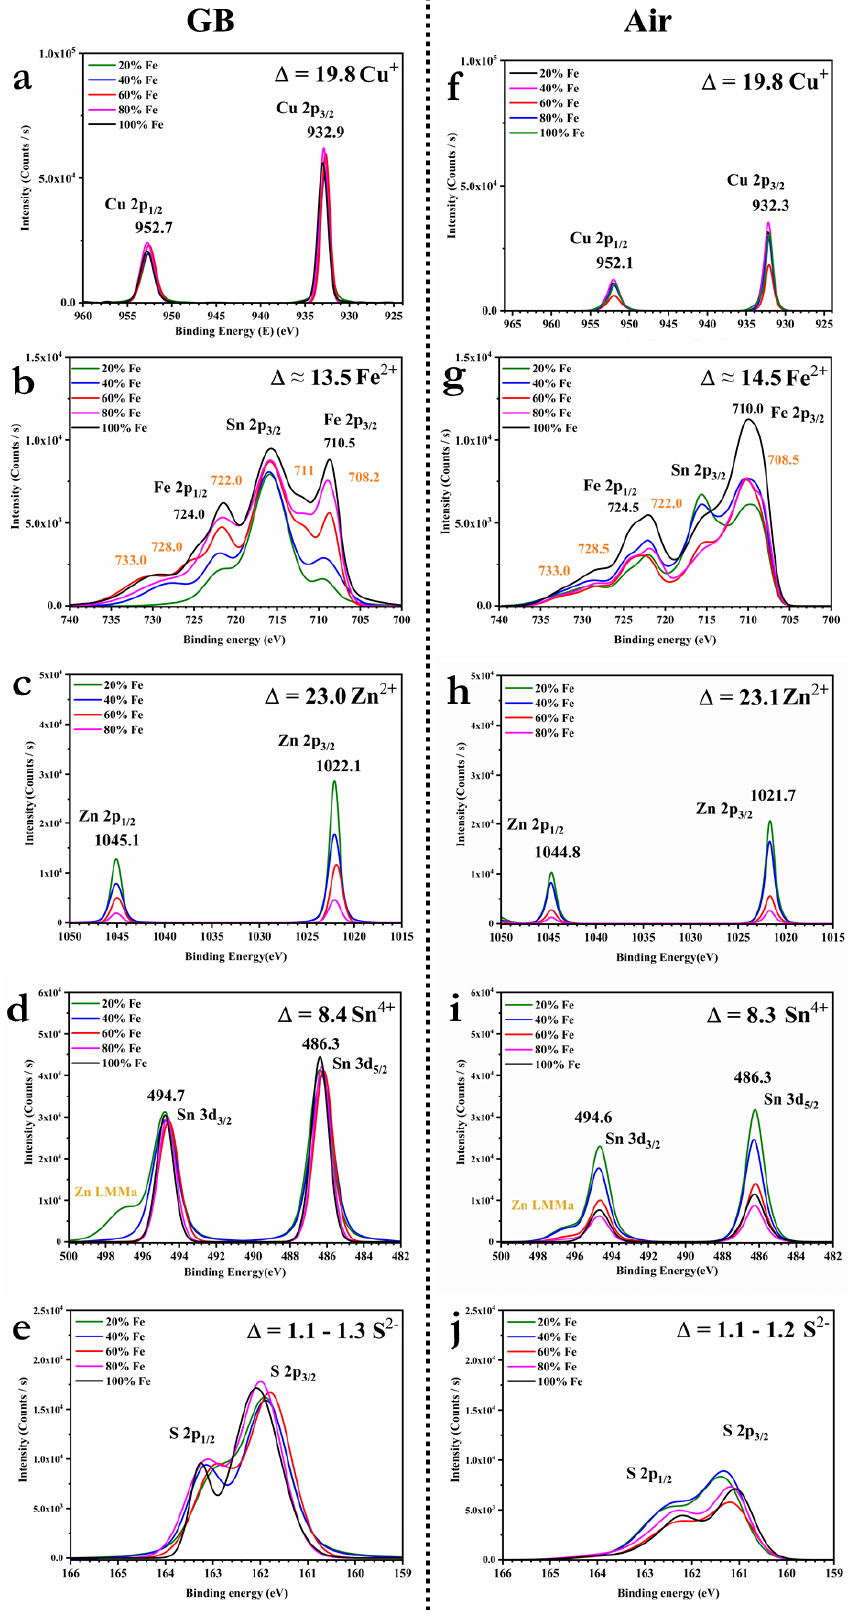
Figure 7. XPS spectra of the high-resolution core level for Cu 2p, Zn 2p, Fe 2p, Sn 3d, and S 2p regions of the 20%, 40%, 60%, 80%, and 100% C(Z,F)TS thin films, made in glovebox ( a – e ) and air ( f – j ).